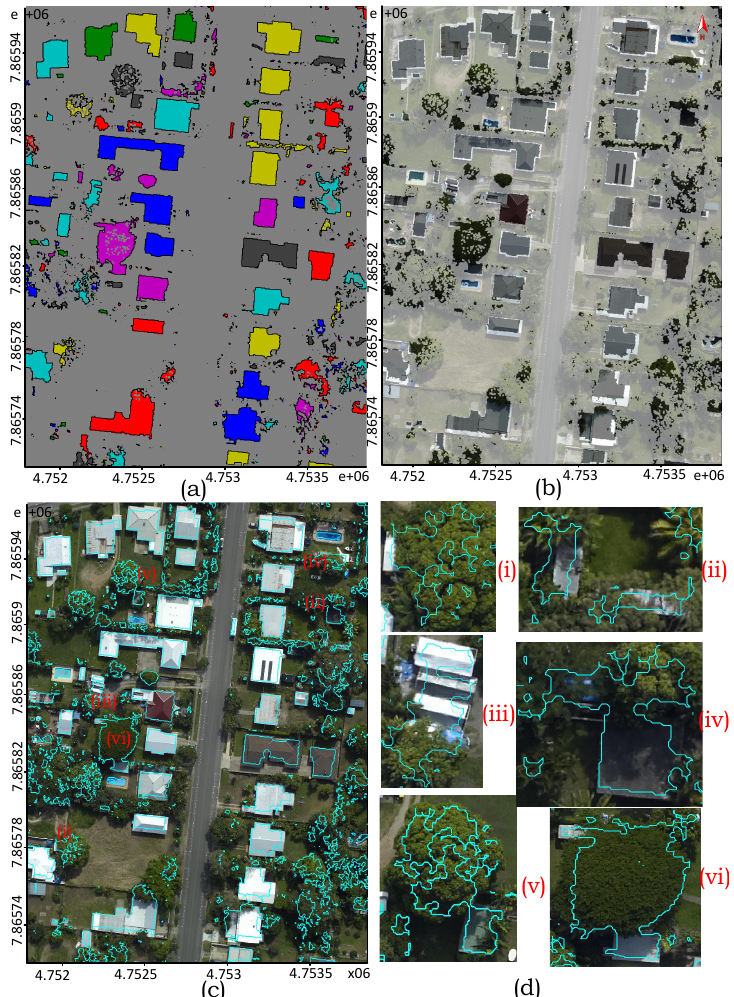
Figure 6. ( a ) Connected components extracted from the building mask of test data; ( b ) Overlaying building mask and orthoimage (misalignment and squeezed boundaries); ( c ) Boundaries of candidate regions sketched on input orthoimage; and ( d ) Complex scenes representing false boundary delineation from (i) to